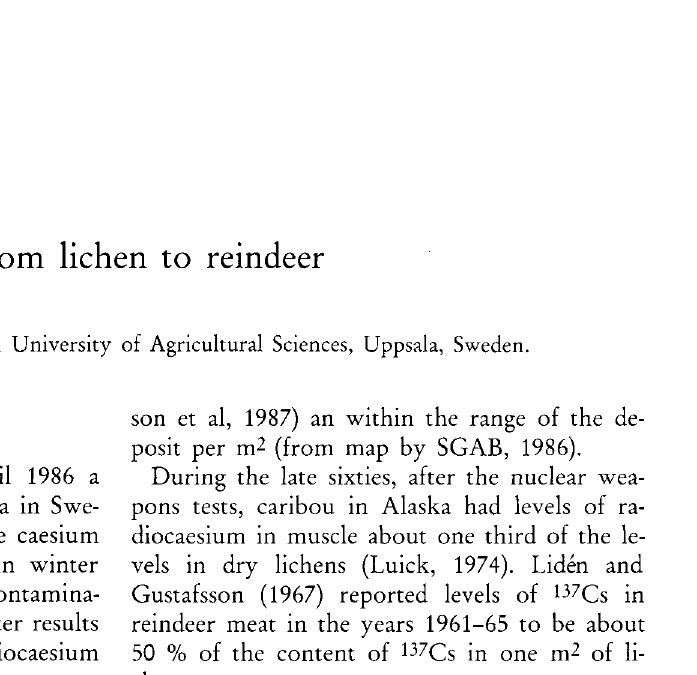
Table 1. Radiocaesium fallout (kBq 137 Cs/m 2 ), activity concentration of 137 Cs in lichens, Cladina arbuscula, (kBq/kg d.w.) and in reindeer meat (kBq/kg) from five saami